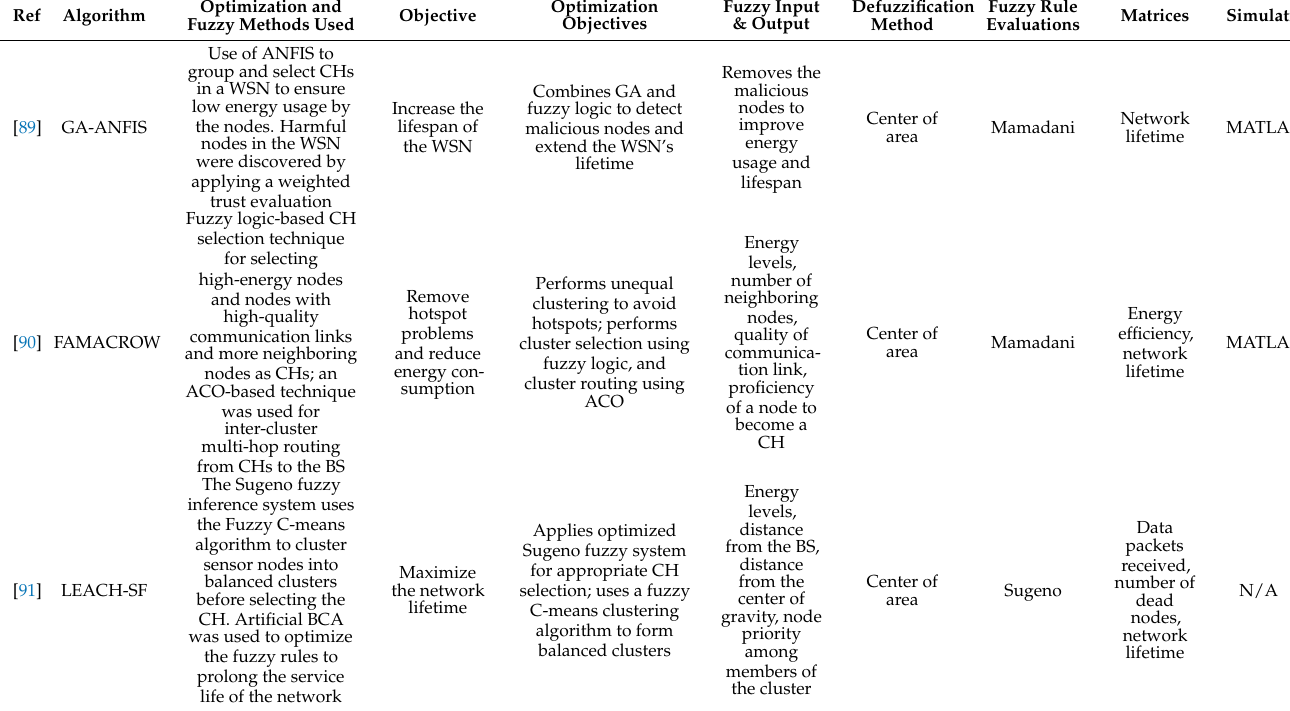
Table 7. Comparison of studies involving fuzzy hybrid